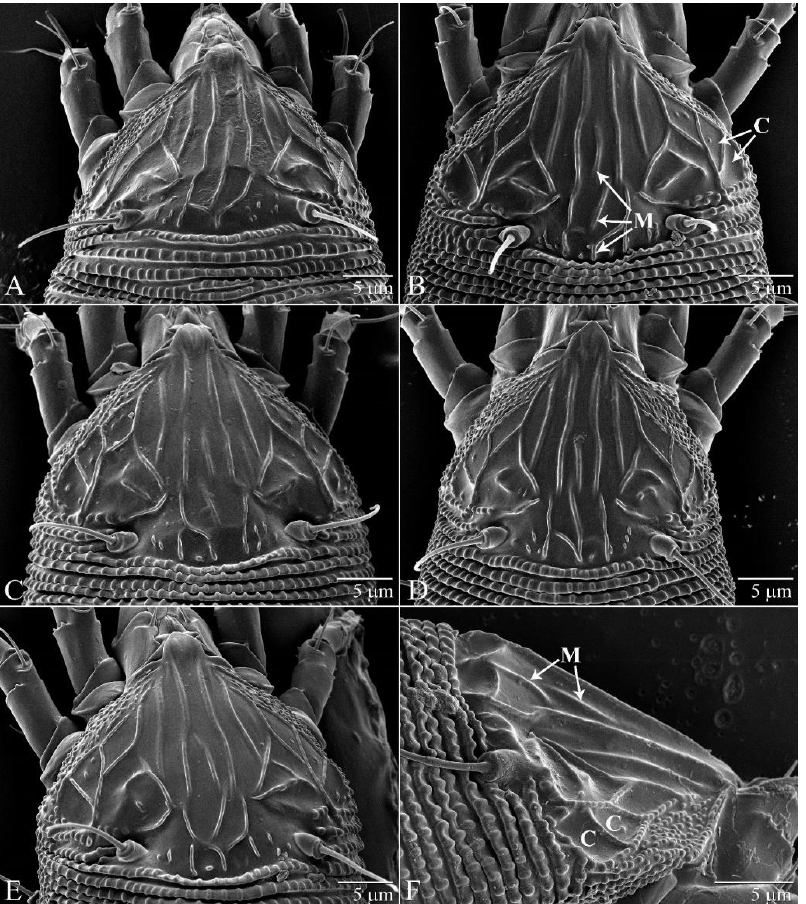
Figure 3. Variation of the prodorsum of LEM from Florida and Hawaii examined under Low-Temperature SEM (LTSEM), following the technique delineated by Bolton et al. [22] ( A )–( E ) Dorsal view of Florida specimens (unknown instars) (only ( B ) is labeled). Note that the median line is sometimes broken anteriorly and/or posteriorly. The arrangement of the ridges in the posteromedian region also varies dramatically so that the posterior part of the median line can run centrally, or curve left or right. ( F ) Lateral view of Hawaii specimen (unknown instar), showing the broken median line and the two additional lateral cells also observed in the Florida specimens. M = Median line; C = Cells missing from figure of Keifer [6]. Adults 110-135 μ m long.